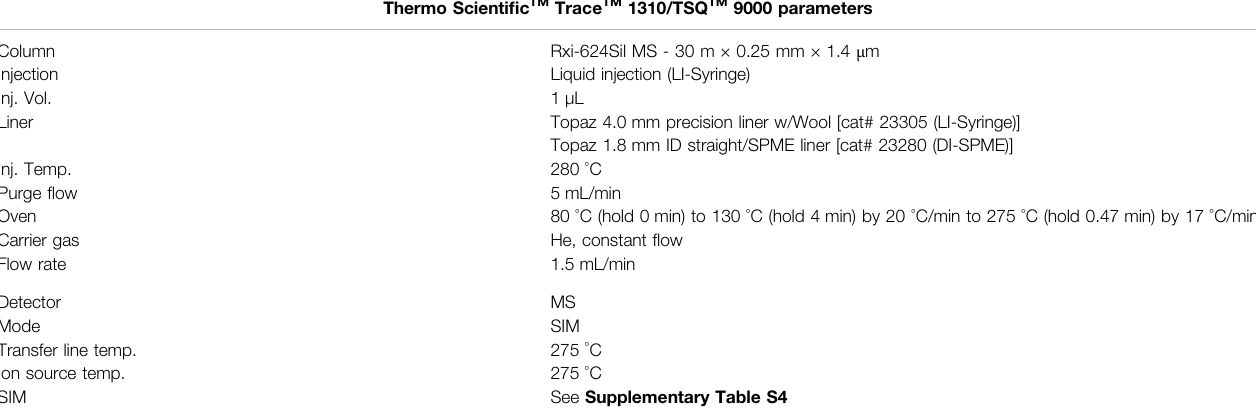
TABLE 3 | Analytical parameters for evaluating terpenes in cannabis with DI-SPME Arrow and LI-Syringe.